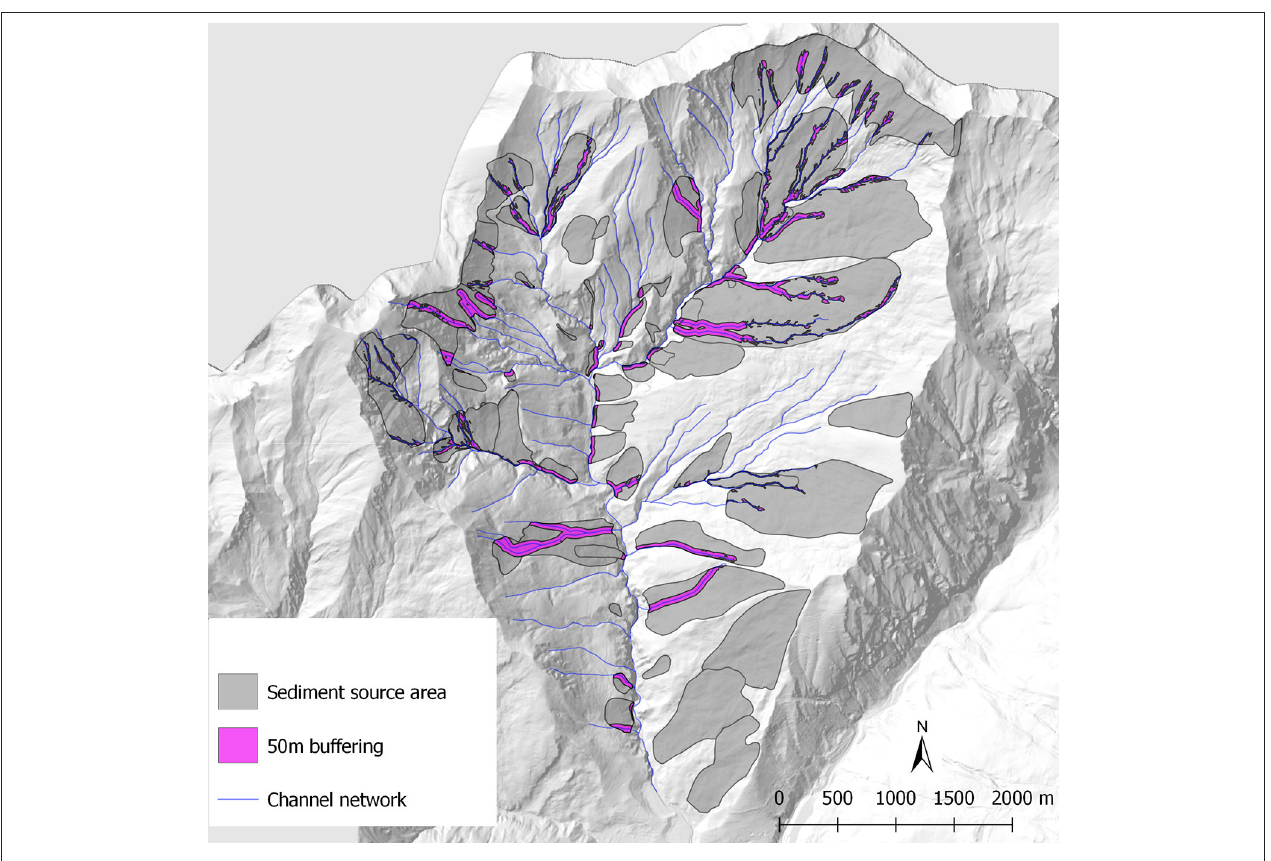
FIGURE 10 | Initial sediment input used in the numerical runs.